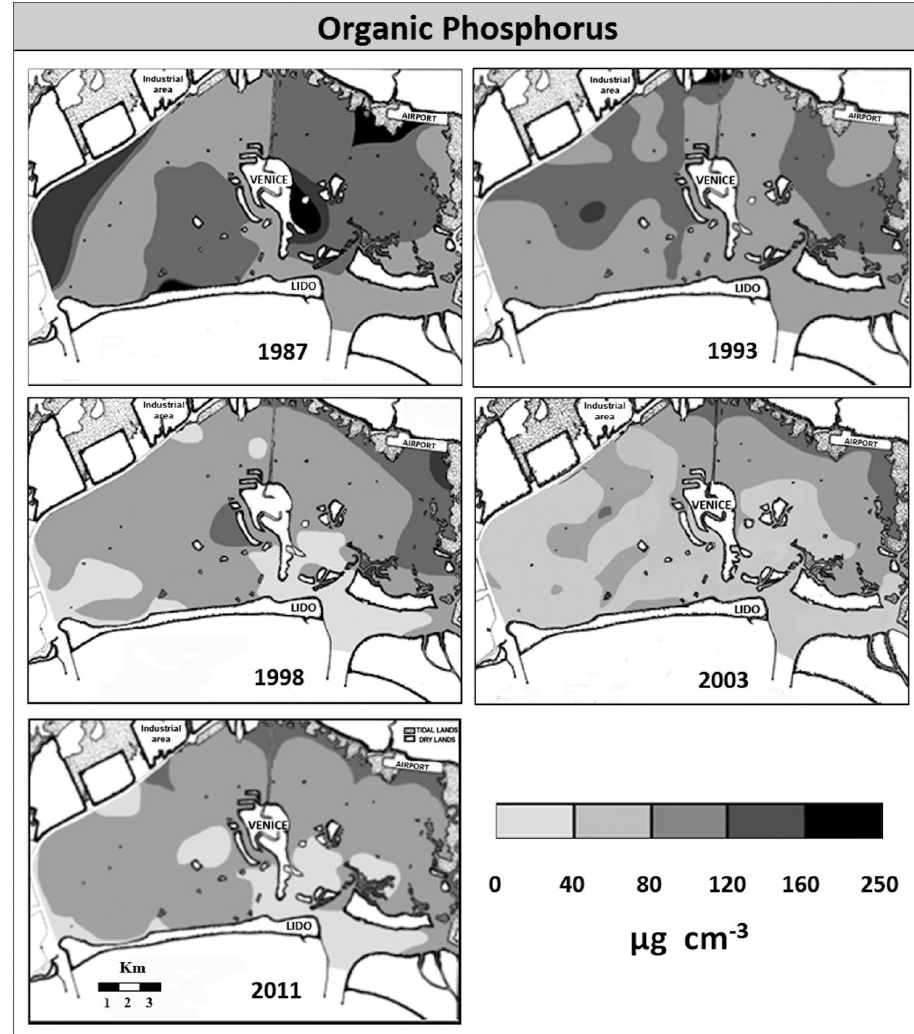
Figure 3. Maps of the organic phosphorus distributions in the 5 cm surface top layer of the central lagoon basin in 1987, 1993, 1998, 2003 and